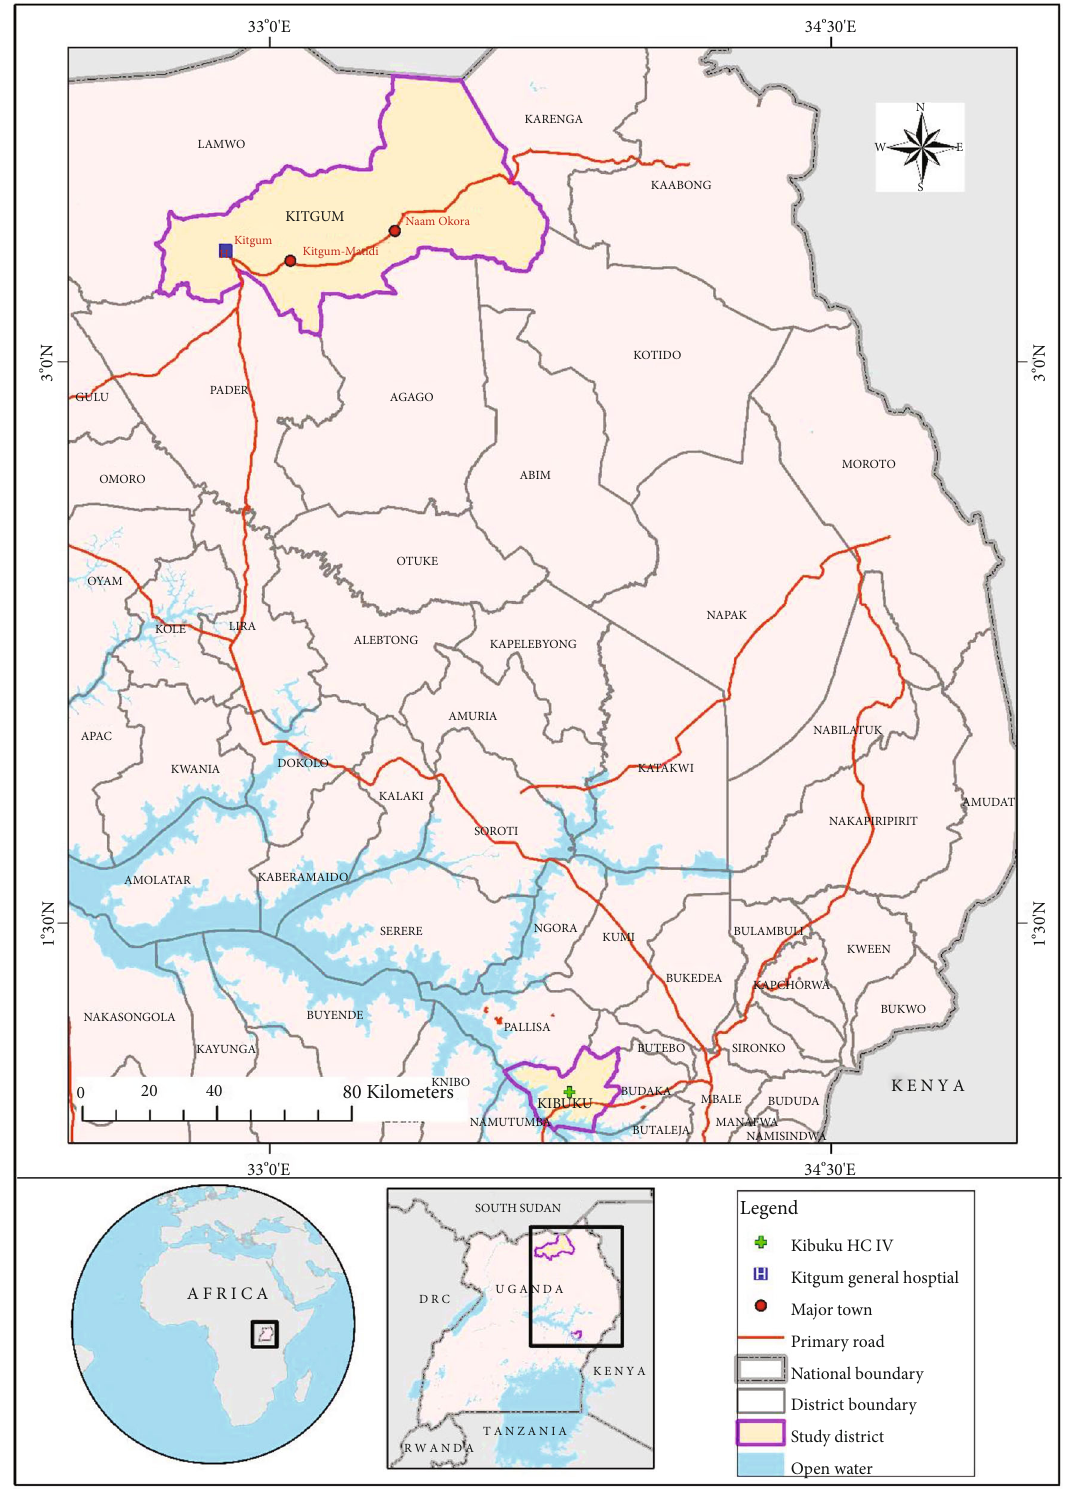
Figure 1: Study sites from both low and high endemic regions and the neighboring catchment